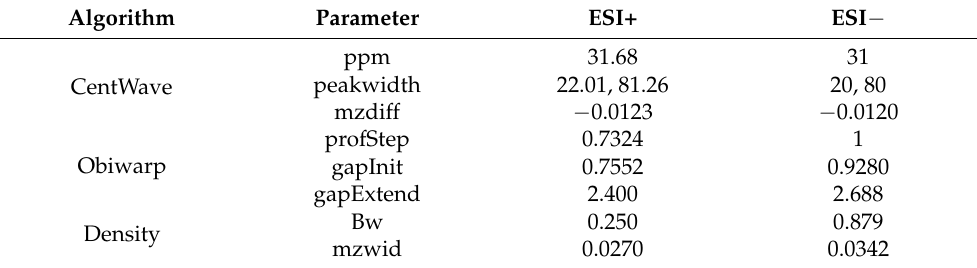
Table 1. XCMS parameters for plasma samples at both ionization modes used in this